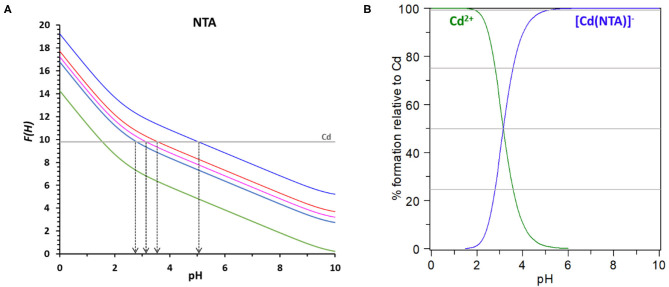
(A) The D(H) function for NTA is reported in red, the F(H) functions for the system Cd-NTA with total cadmium 2 × 10−5 M and R = 50 are reported for the 0% of complex formation (green), 25% (light blue), 50% (pink), 75% (red) and 99% (blue). (B) Speciation plot for the system Cd-NTA with [Cdtot] = 2 × 10−5 M and [NTAtot] = 1 × 10−3 M (R = 50).